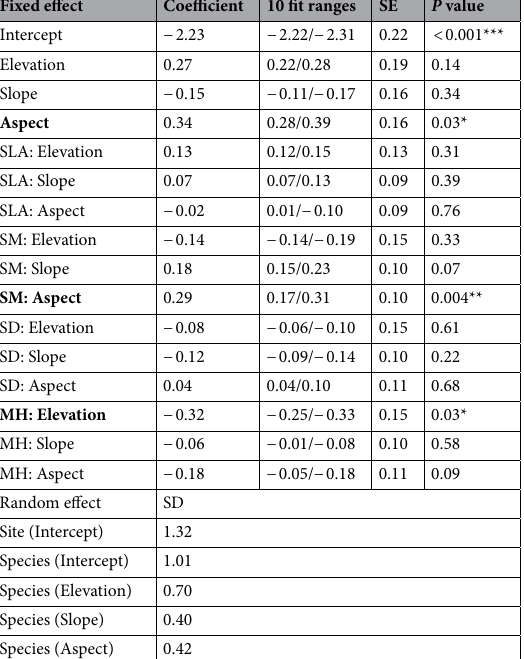
Table 1. Summary of the fixed effects and random effects from our topographic model. * P < 0.05, ** P < 0.01, *** P <